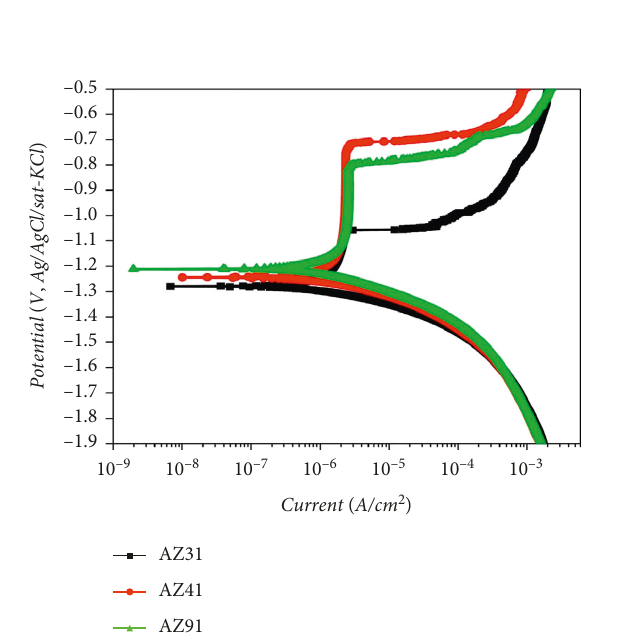
Figure 4: The corrosion resistance of the specimens by polarized dynamic potential experiment.